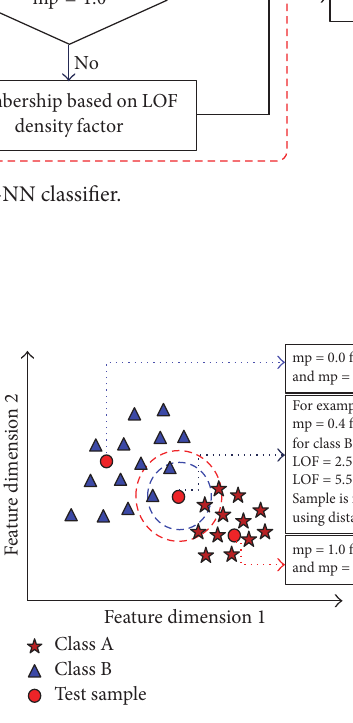
Figure 7: Classifying a test sample using the enhanced 𝑘 -NN